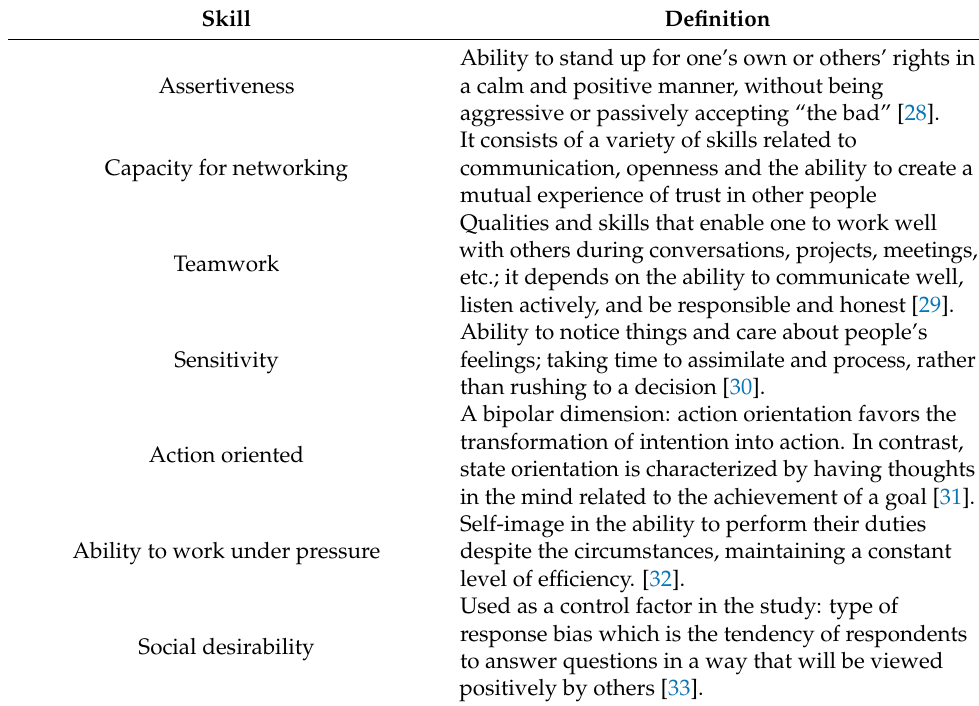
Table 1. Definitions of the skills used the